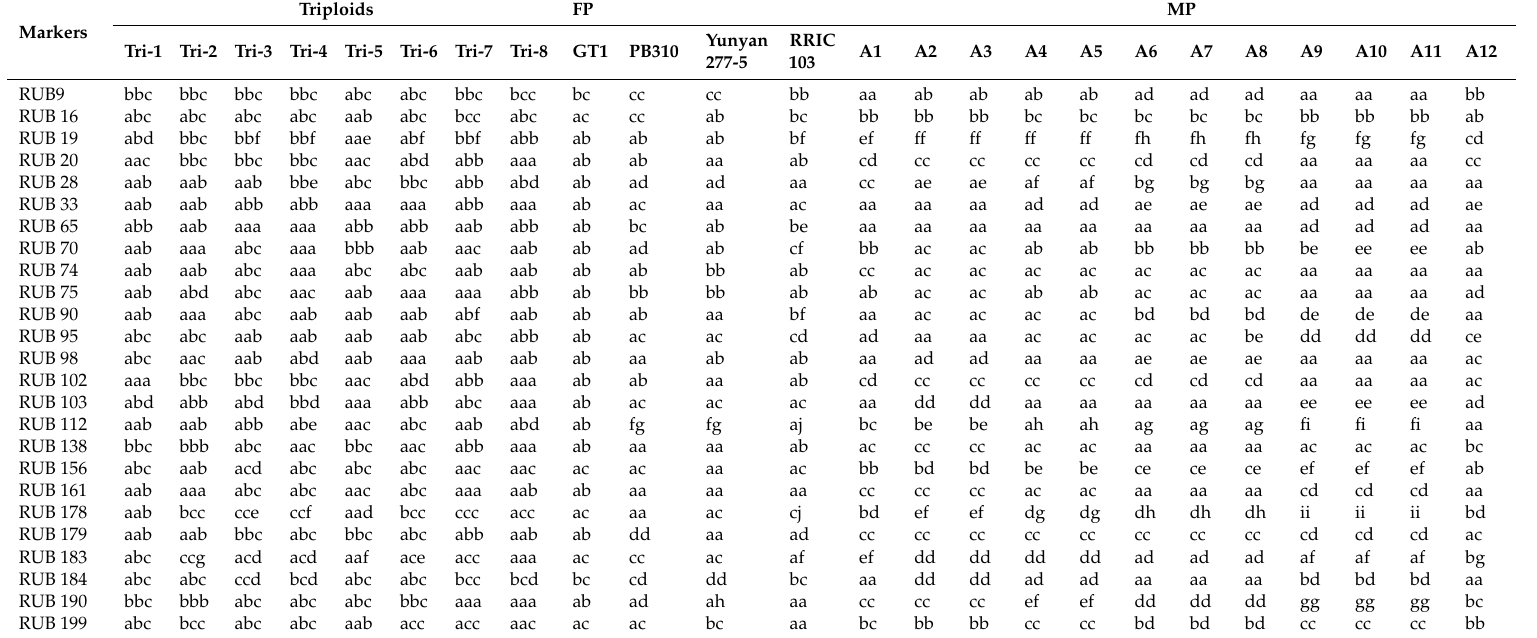
Table 3. Allelic configuration comparing triploids, female parent GT1, and candidate male parents of rubber trees.